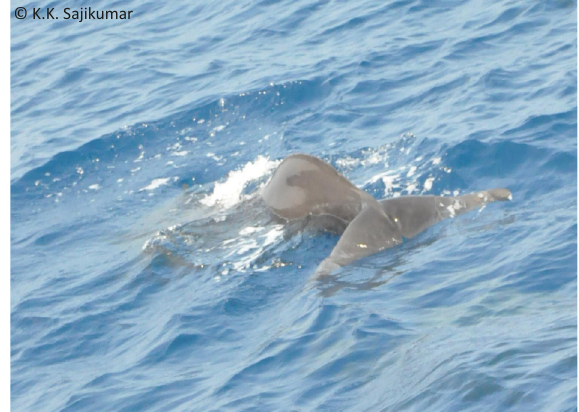
Image 10. The whale arching peduncle.